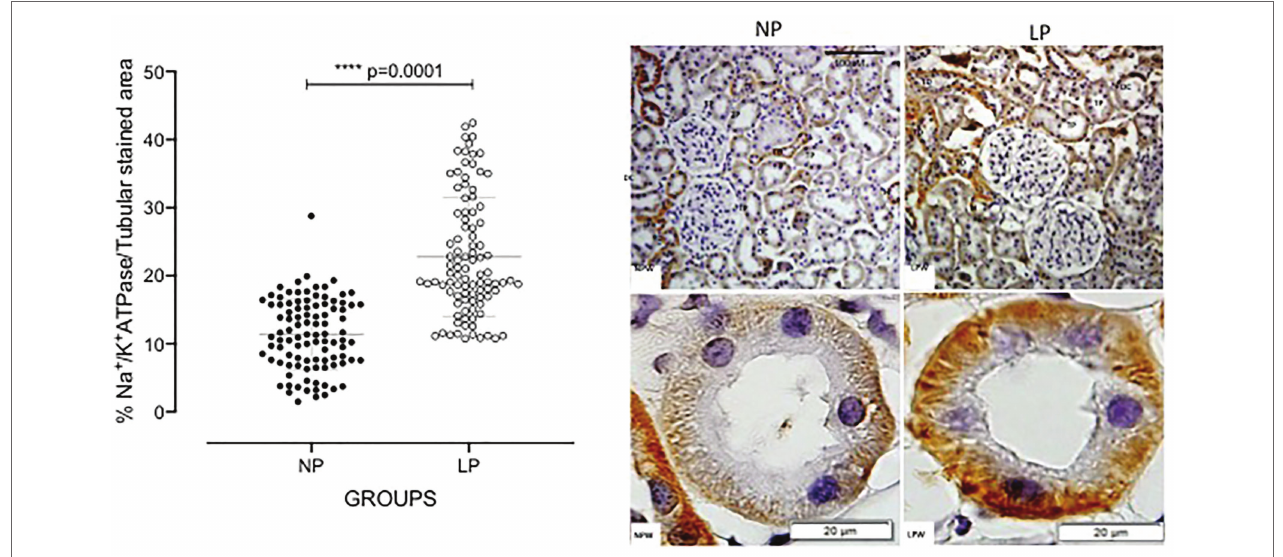
FIGURE 5 | Kidney Na/K-ATPase expression by immunohistochemistry in 24-week-old LP progeny ( n = 5) compared with age-matched NP progeny ( n = 5). A magnification of 400× and 1000× was used. The scale bar can be found at the bottom right of each figure. Five cortical and medullar fields of each histological section were analyzed, and the average immunoreactivity reading was determined. Data are presented as scatter dot plots on the left; unpaired Welch’s t-test was used for data analysis. The level of significance was set at p < 0.05.